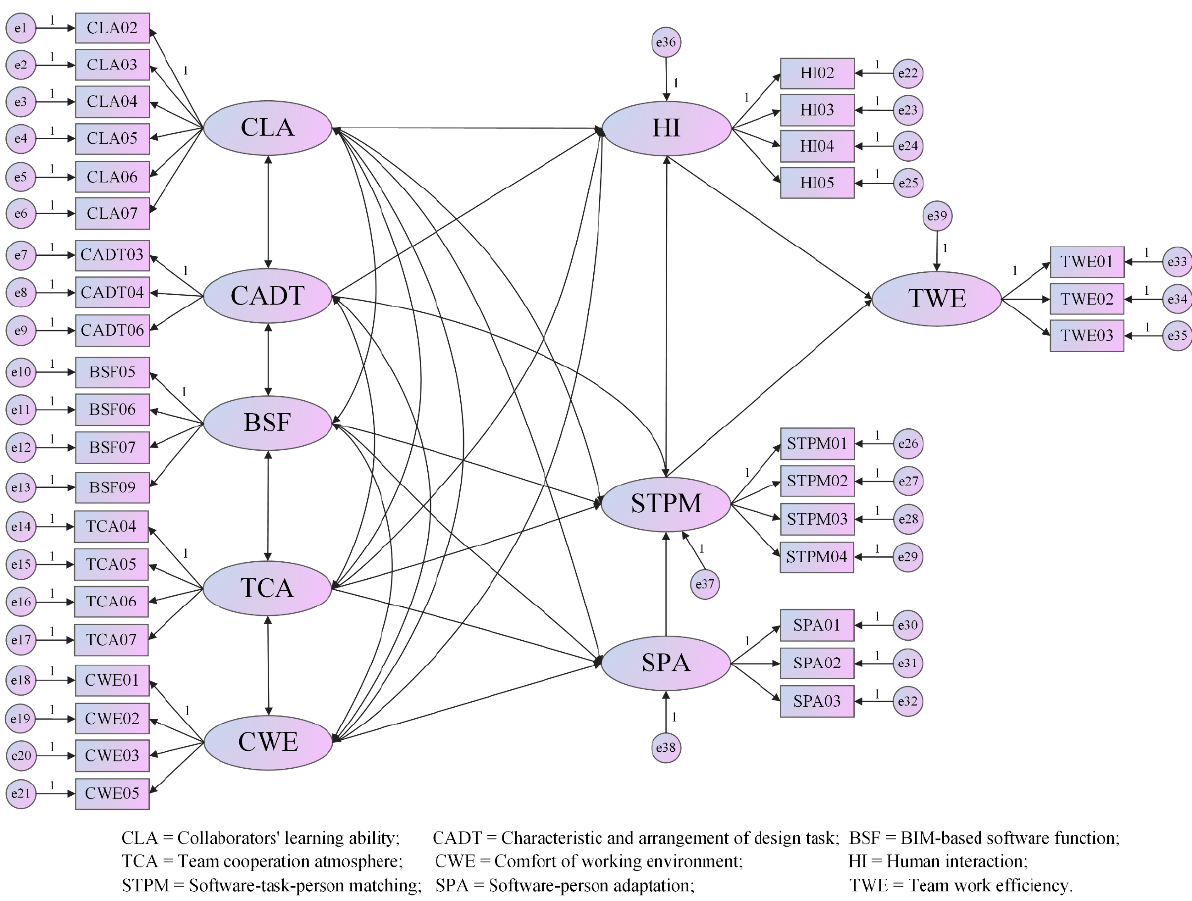
Figure 3. The initial hypothetical model of teamwork efficiency in BIM-based collaborative design.